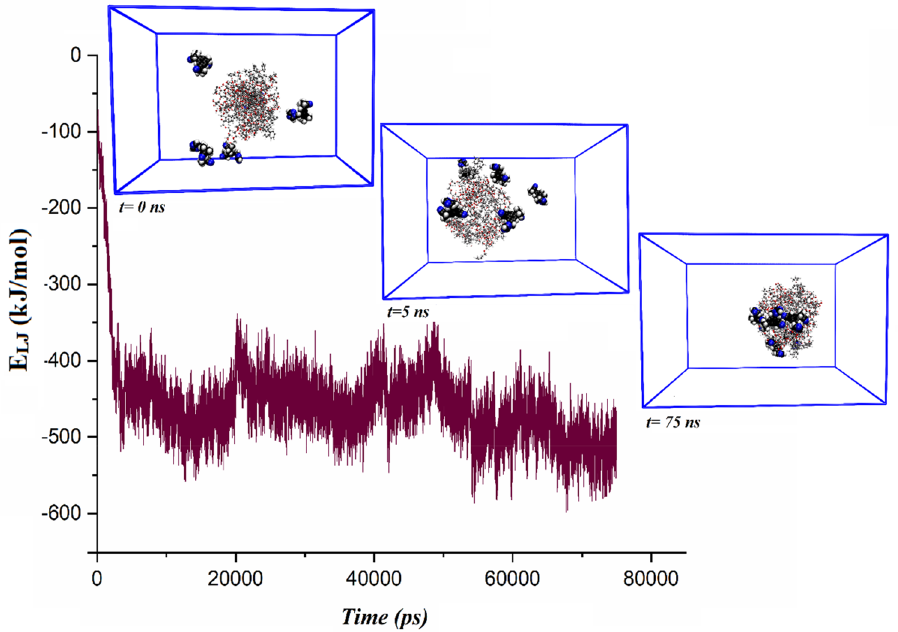
Figure 7. The L–J energy variations in ANS-loading process.